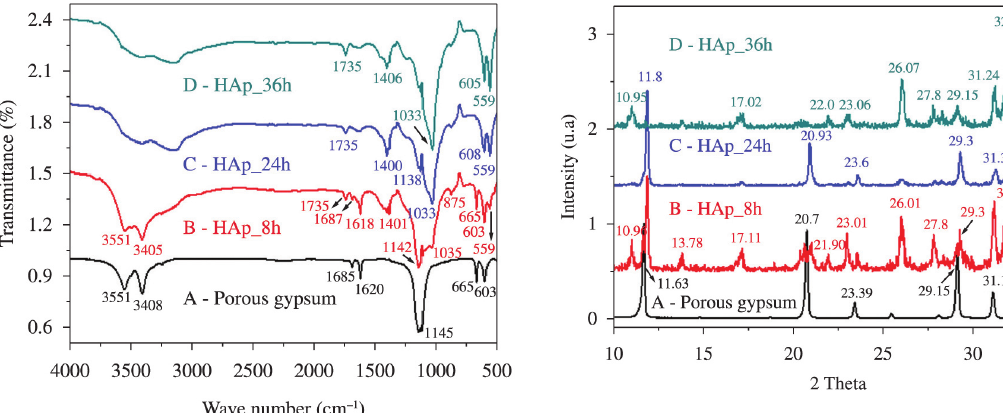
Figure 6. X-ray diffractograms: A) for porous gypsum; B), C) and D) for HAp after 8, 24 and 36 hours conversion time, respectively. Table 2. Crystallographic planes related to HAp and to dihydrate